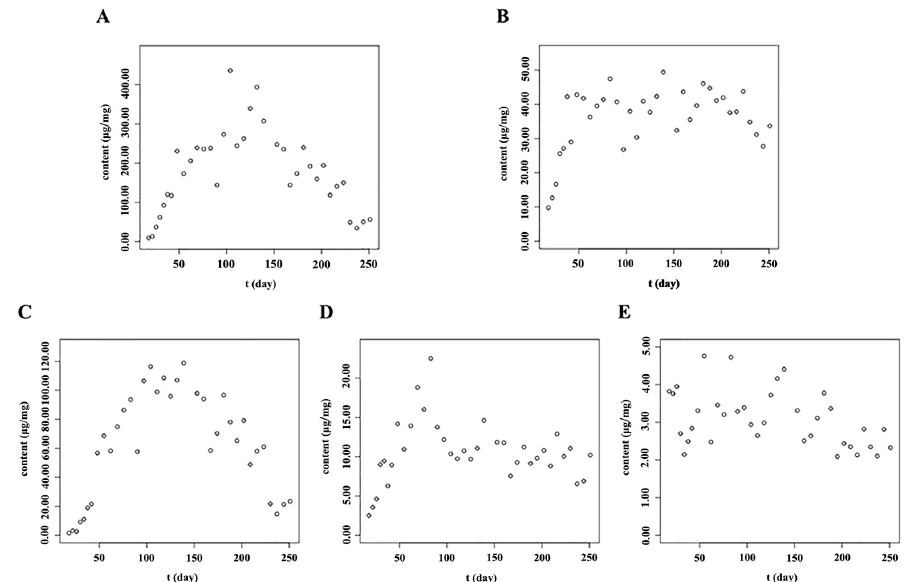
Figure 7. Accumulation patterns of main flavonoids in the leaf of S. baicalensis . ( A ): Isocarthamidin-7- O - β - D -glucuronide; ( B ): Scutellarin; ( C ): Carthamidin-7- O - β - D -glucuronide; ( D ): Apigenin-7- O - β - D -glucuronide; ( E ): Baicalin; The units “ μ g/mg” meant the contents of analytes in per mg of freeze-dried samples.